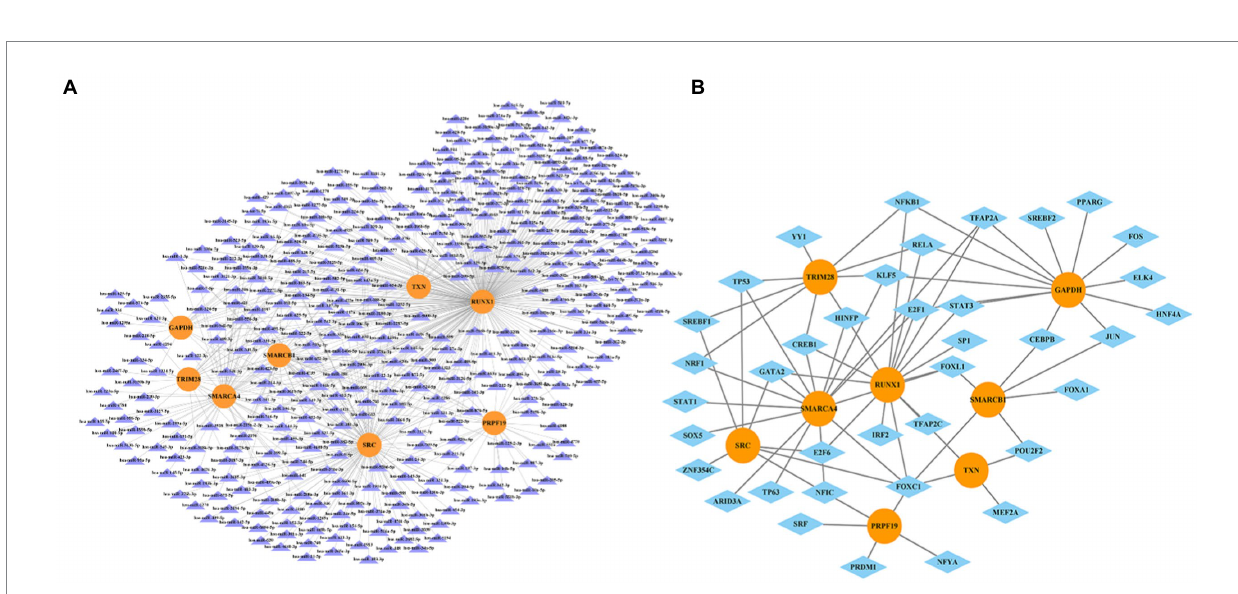
FIGURE 10 The miRNA-gene network (A) and transcription factor-gene regulatory network (B) . The orange circles represent hub-genes, purple triangles represent miRNAs and blue diamonds represent